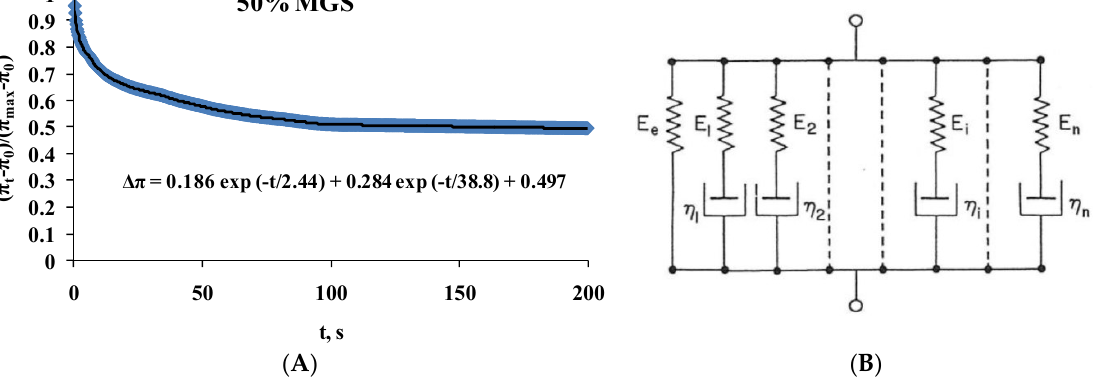
Figure 6. ( A ) Example of double exponential decay fit (R 2 = 0.98) with Equation (1) of the stress relaxation transients of 50% saturated MGS film. The values of the fitted parameters are presented on the chart; ( B ) Schematic presentation of the generalized Maxwell model (represented by Equation (1)) consisting of parallel Maxwell spring-and-dashpot elements and a spring element denoting the equilibrium elasticity E e . See main text for details.